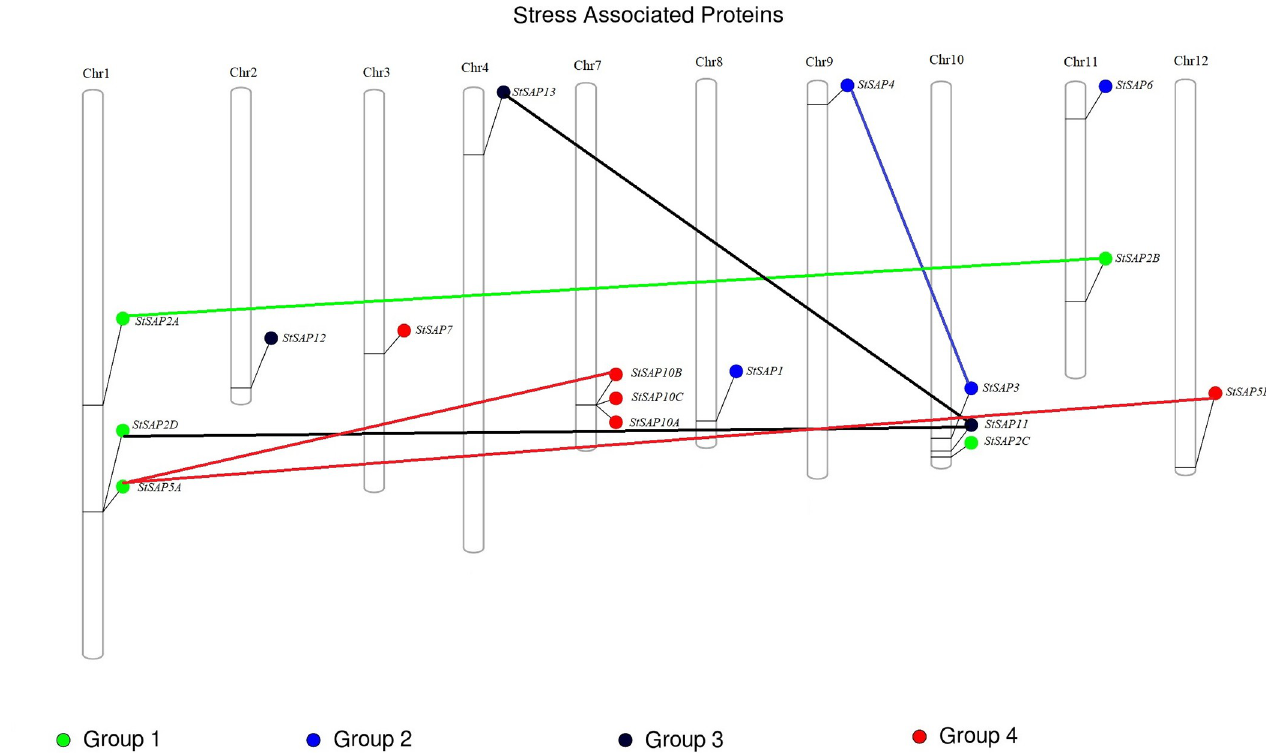
Fig 4. The presence of StSAP genes on S . tuberosum chromosomes. The lines connecting the genes show segmental duplication.